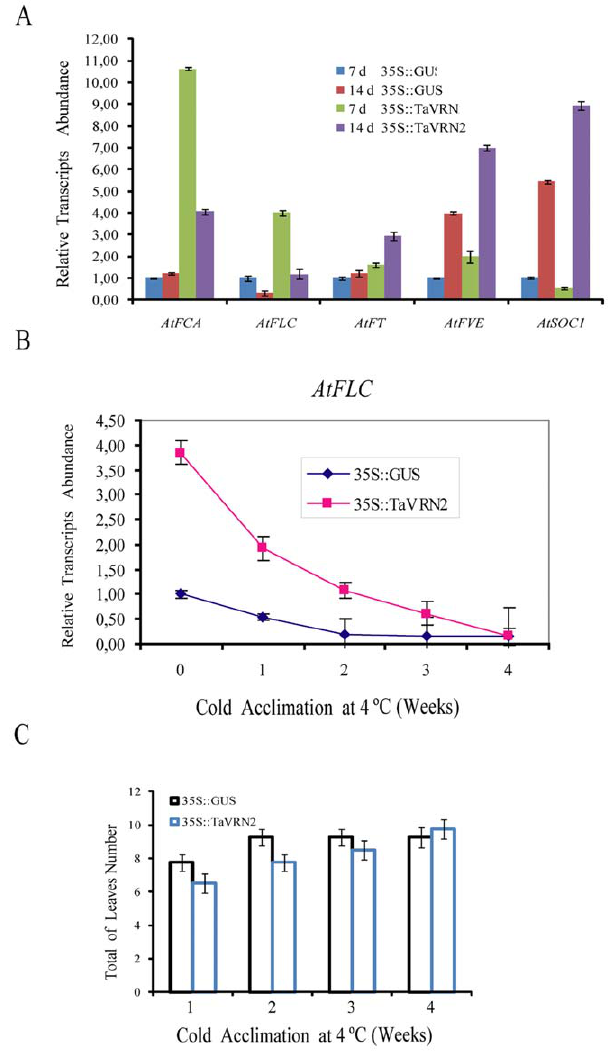
Figure 5. Effect of TaVRN-B2 overexpression on Arabidopsis flowering genes. A) Expression pattern of flowering genes under unvernalized conditions in control ( 35S::GUS ) and transgenic 35S::TaVRN-B2 plants. Seven and 14 days (d) old plants were grown at 20 u C under LD conditions. Relative transcript abundance is normalized in relation to the level of each gene at 7 days of 35S::GUS control sample. B) Expression pattern of FLC under cold acclimation conditions in control ( 35S::GUS ) and transgenic 35S::TaVRN-B2 plants (Line 1). Fifteen days old plants were grown at 4 u C for 5 weeks. Relative transcript abundance in normalized to the 35S::GUS control sample at zero time. C) Total number of leaves (n=32) of cold acclimated control ( 35S::GUS ) and transgenic 35S::TaVRN-B2 plants (Line 1) at bolting